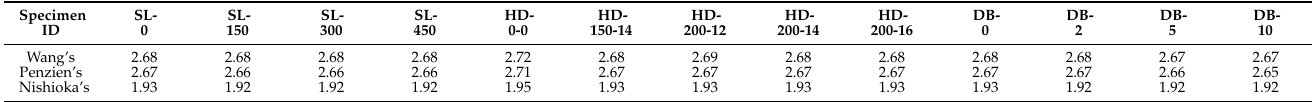
Table 7. Interaction coefficient R using Wang’s, Penzien’s, and Nishioka’s